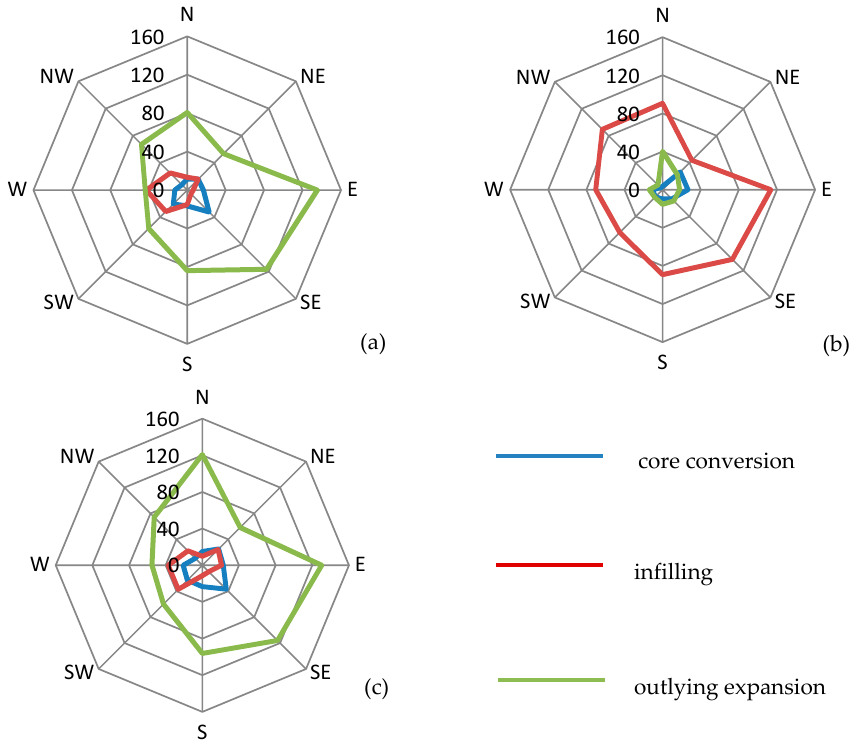
Figure 8. Distribution of expansion types in different directions of the urban fringe in Changchun